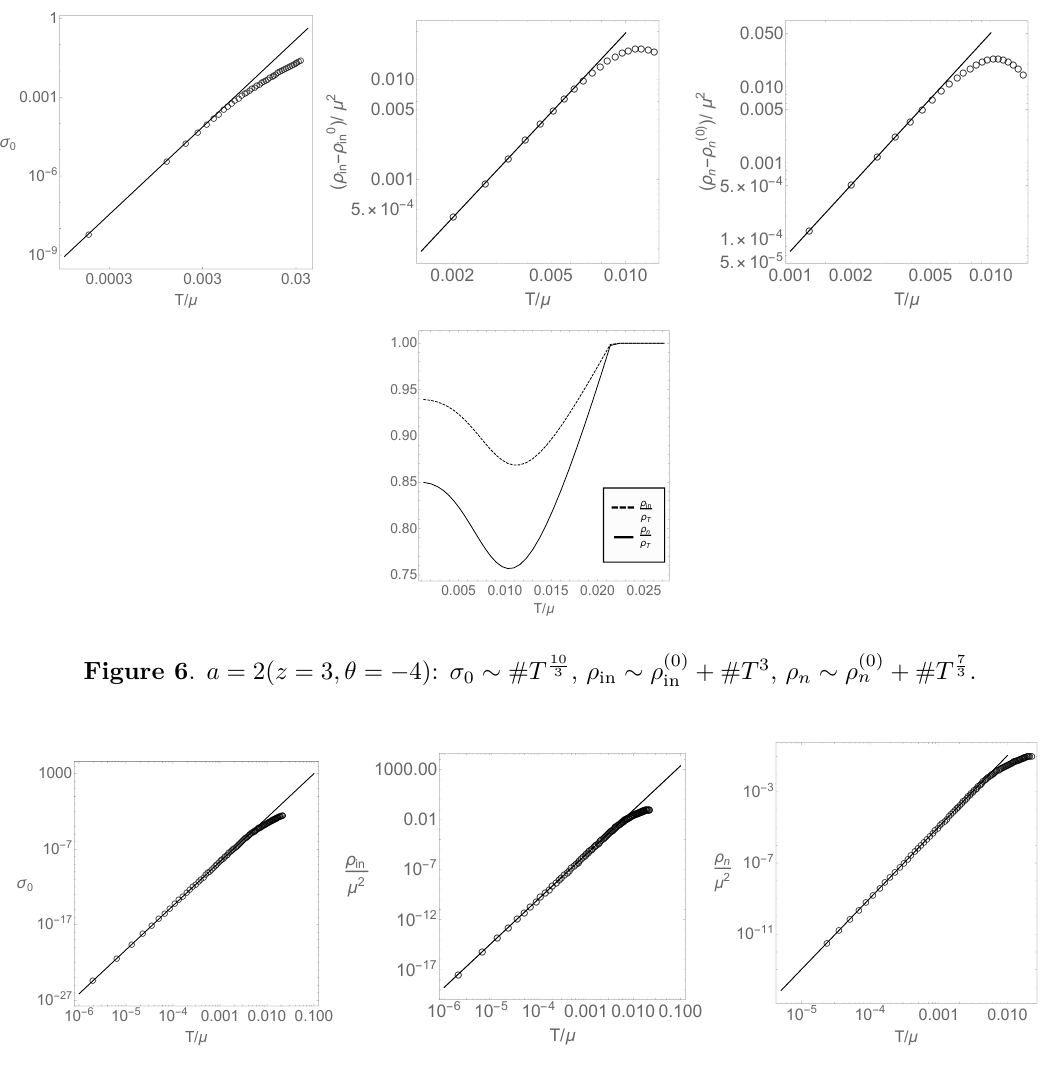
Figure 7 . a = 1( z = 1 , θ = − 1 , ξ = 1) : σ 0 ∼ # T 5 . 83 , ρ in ∼ # T 4 . 42 , ρ n ∼ # T 4